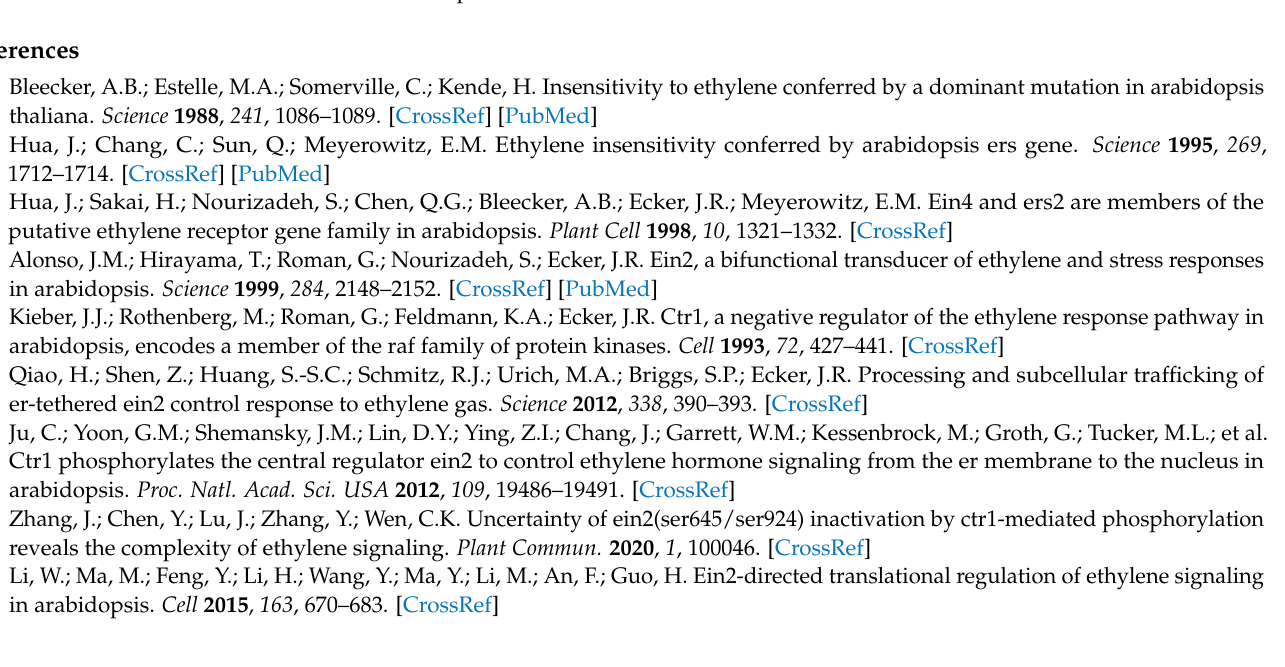
Figure S2: graphical ribo-seq quality indexes. Methods and analyses of the ribo-seq provided by